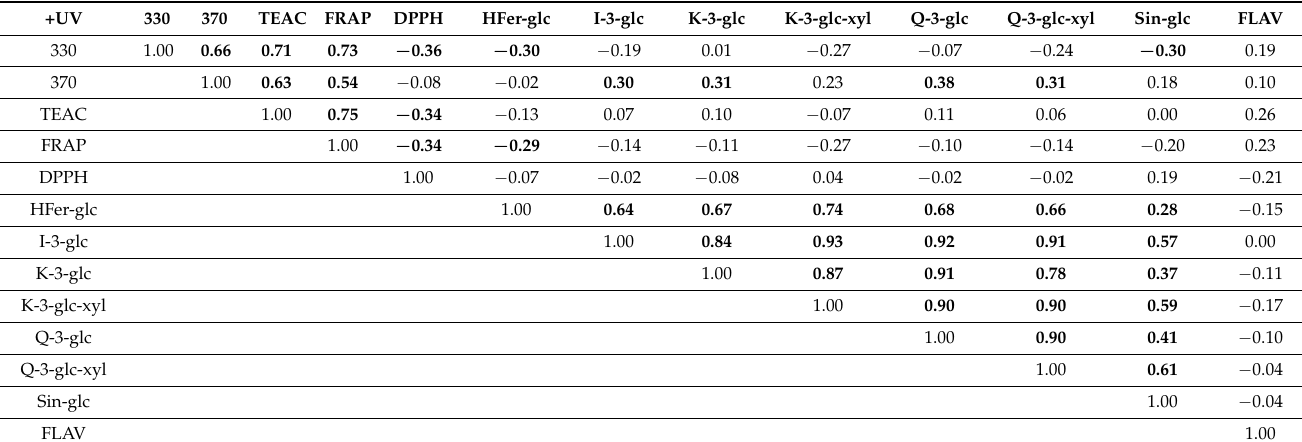
Table 4. Correlation coefficients of UV absorption at 330 and 370 nm in absorbance per 0.75 cm 2 and antioxidant activity (TEAC, FRAP, and DPPH) in mM Troxolequivalent per g dry matter, soluble flavonoid glycosides, and hydroxycinnamic acids in mg per g dry matter, and flavonoid content (FLAV) in relative arbitrary units (Dualex) in +UV plants from Experiment 1 (targeting diurnal rhythm). Bold values represent significant correlations at p ≤ 0.05. I: isorhamnetin;